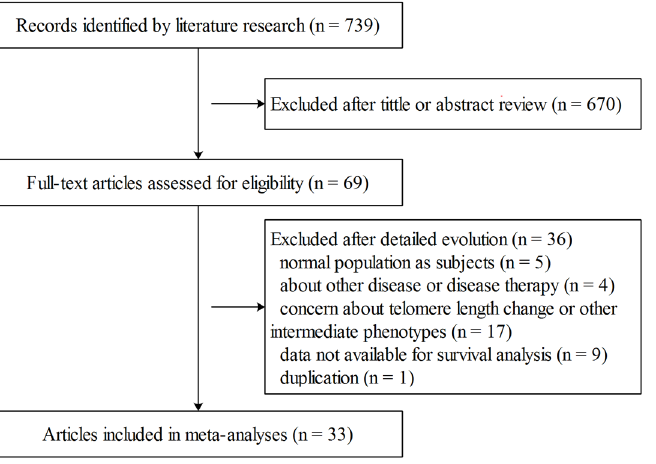
Fig 1. Flow chart for the process of selecting eligible